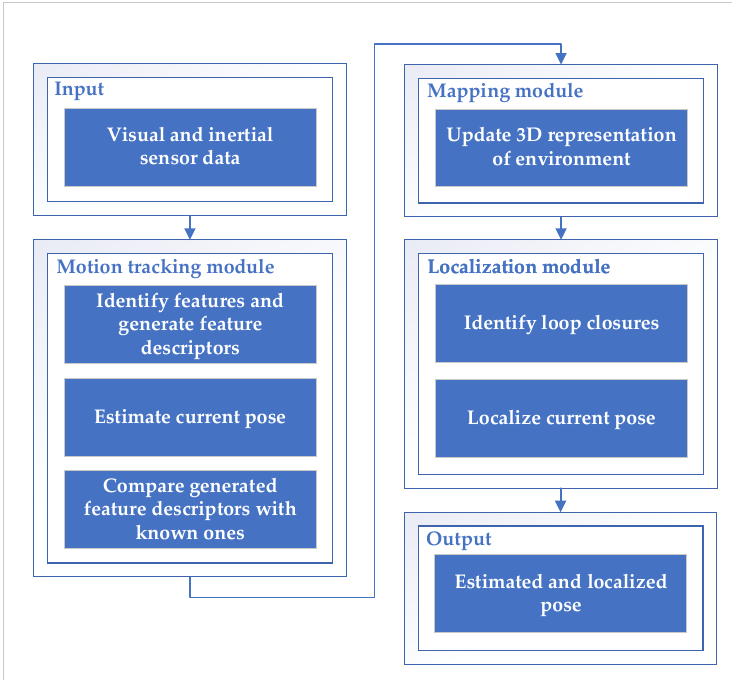
Figure 2. The concept of the ARCore concurrent odometry and mapping algorithm